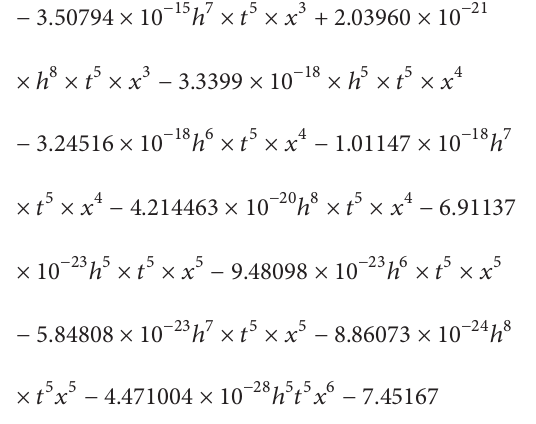
𝑦 𝑦 𝑦 𝑦 𝑦 𝑦 𝑦 𝑦 0 + 1 + 2 + 3 + 4 + 5 + 6 + 7 + 8